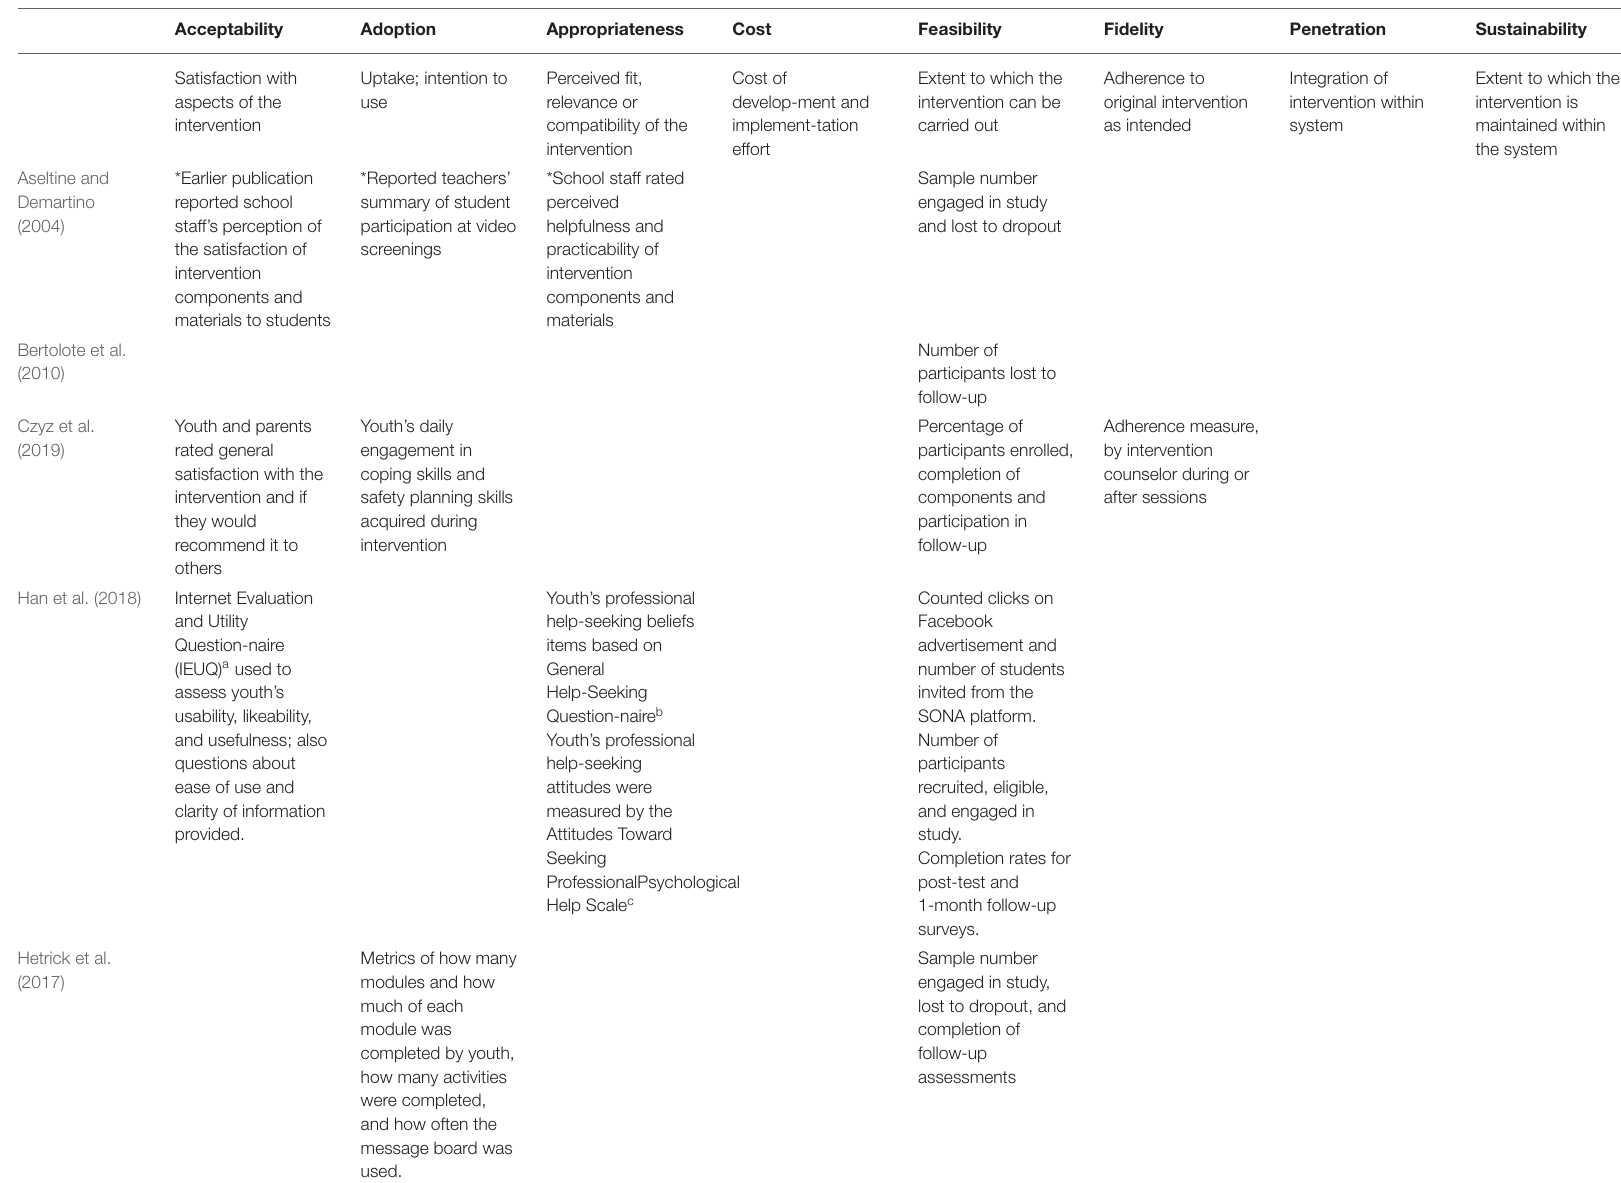
TABLE 3 | Implementation outcomes reported and how they were